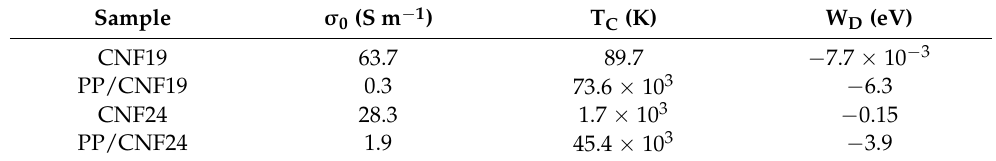
Table 5. Constants σ 0 , T C , and W D determined from VRH model of CNFs and PP/CNF